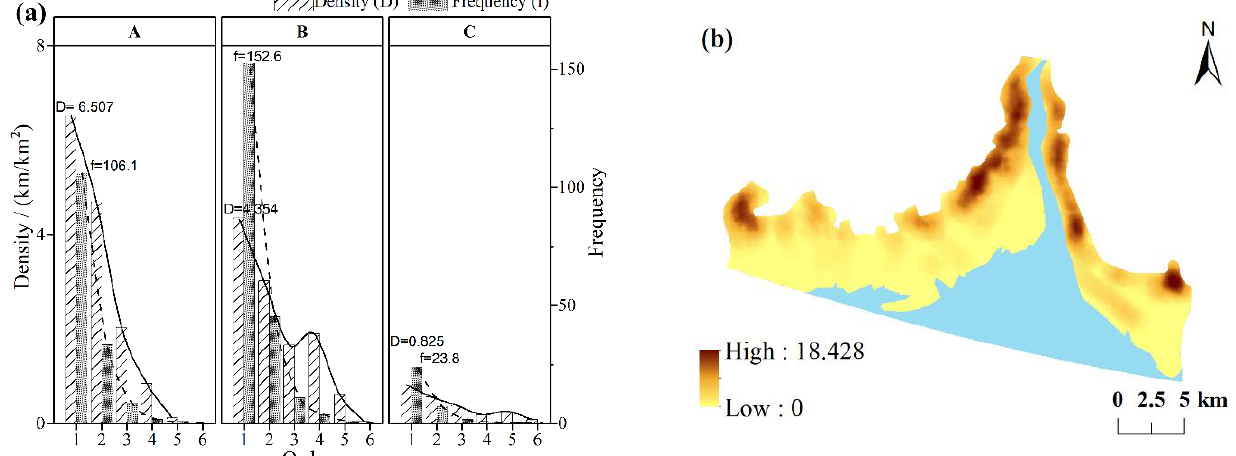
Figure 9. Statistics of ( a ) density and frequency of tidal creeks of different orders and ( b ) total density of tidal creeks in the coastal wetlands of the Liao River Estuary. (A: the supratidal zone; B: the upper intertidal zone; C: the middle intertidal zone.).